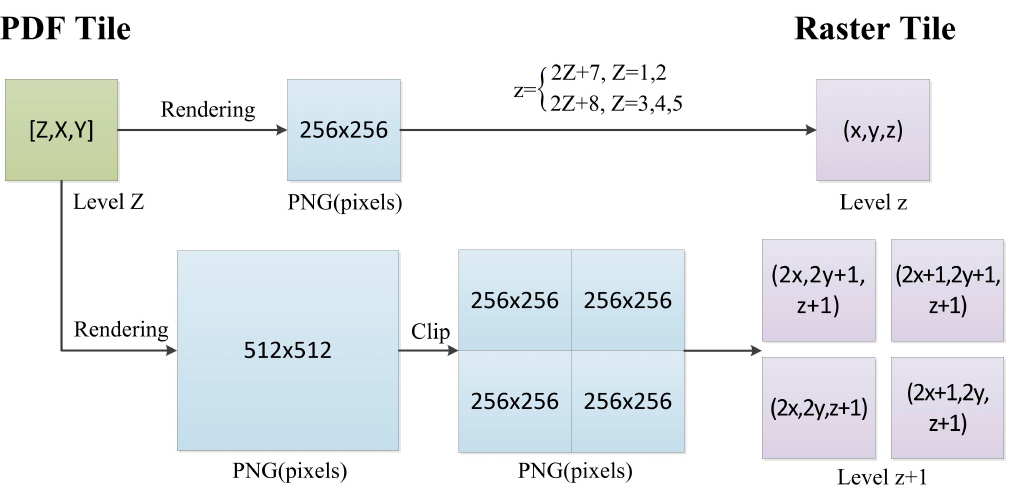
Figure 19. PDF tiles providing raster tiles. Tile codes [Z,X,Y] are tile coordinates (X,Y) under a level Z PDF tile. Tile codes (x,y,z) are tile coordinates (x,y) under a level z raster tile.